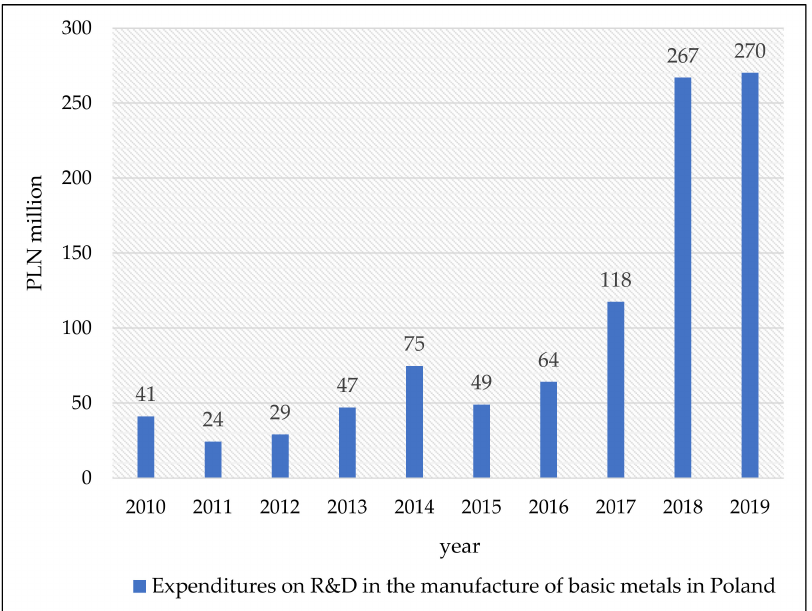
Figure 3. Expenditures on R&D in the manufacture of basic metals in Poland. Source: adapted with permission from Refs. [101–109].